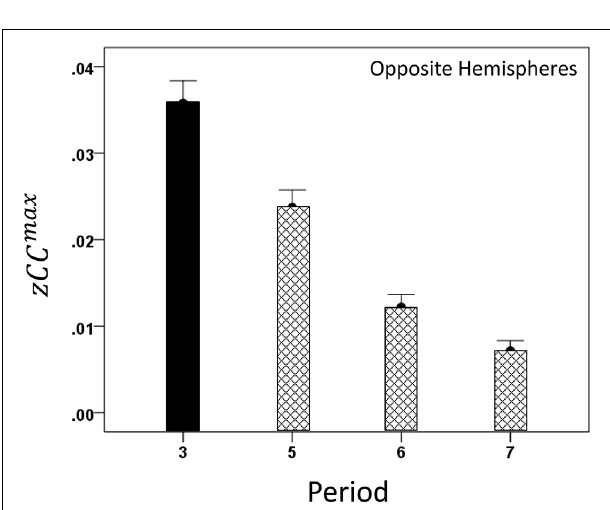
FIGURE 13 | Modulation of opposite-hemisphere zCC max during task periods, peaking at period 3 (see text for details).